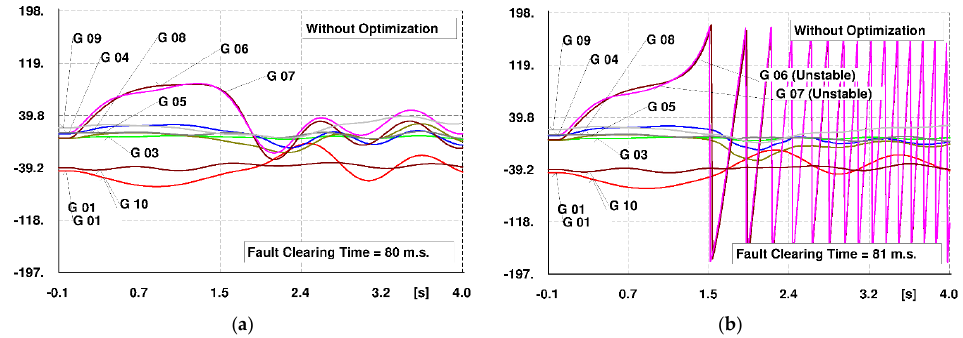
Figure 10. CCT of the system before optimization (for the considered short-circuit fault). ( a ) FCT = 80 m.s. (stable), ( b ) FCT = 81 m.s. (unstable).